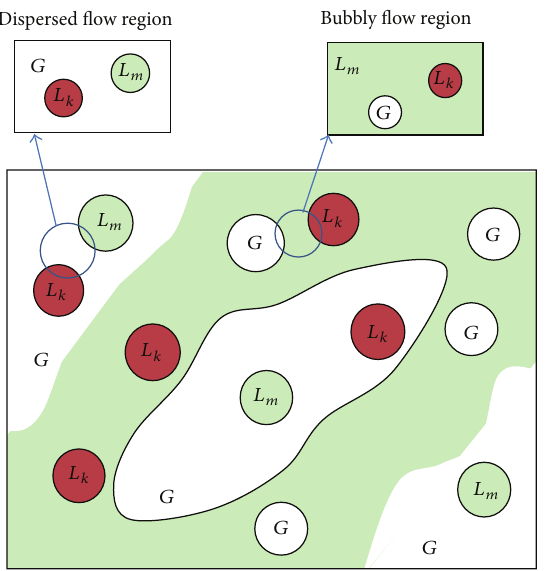
Figure 5: Schematic concept of separating bubbly and dispersed